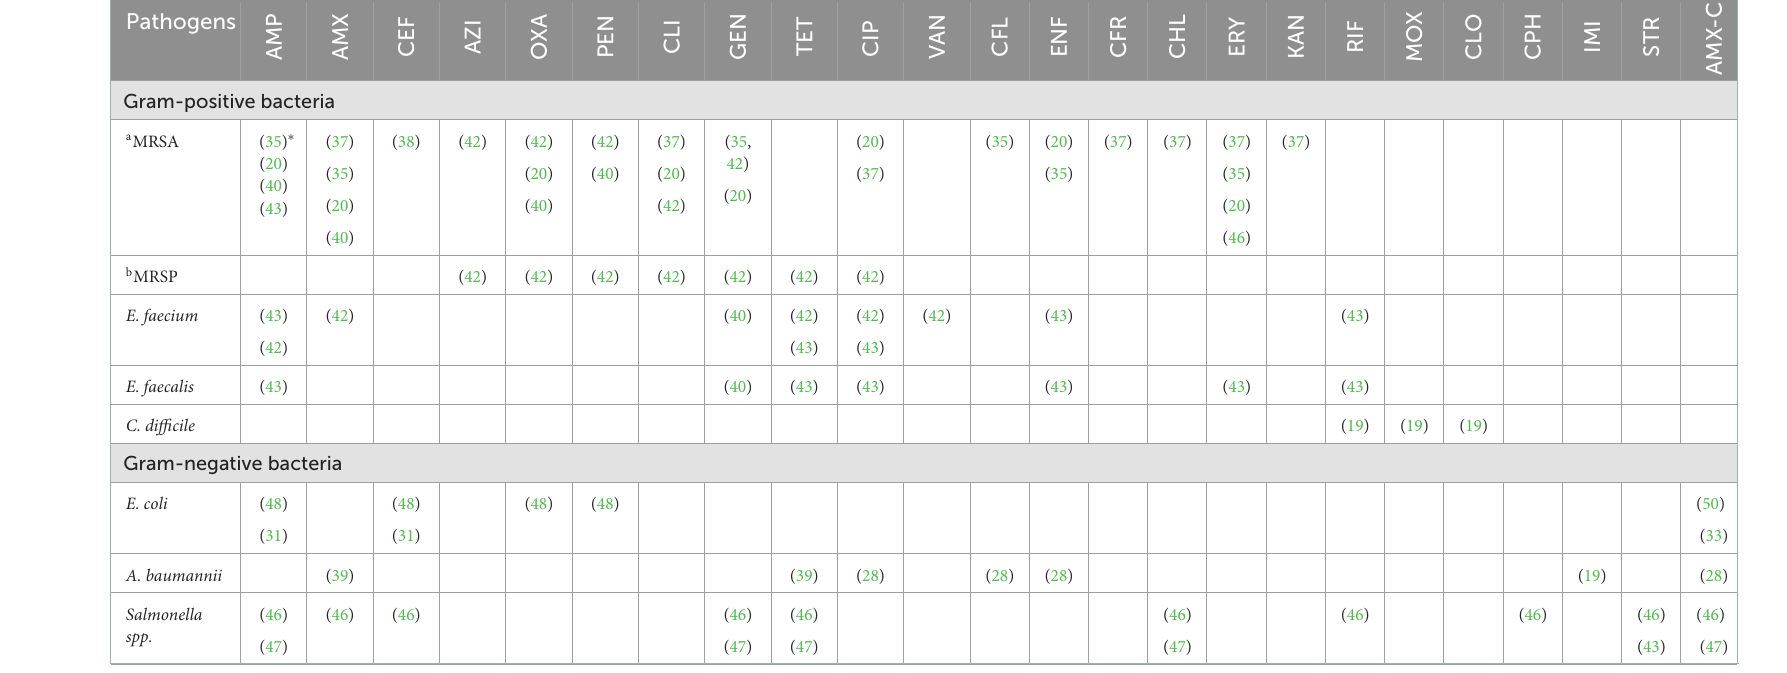
TABLE 5 Phenotypic antimicrobial resistance profile of hospital-acquired infection organisms based on the systematically reviewed papers published from 2000 to